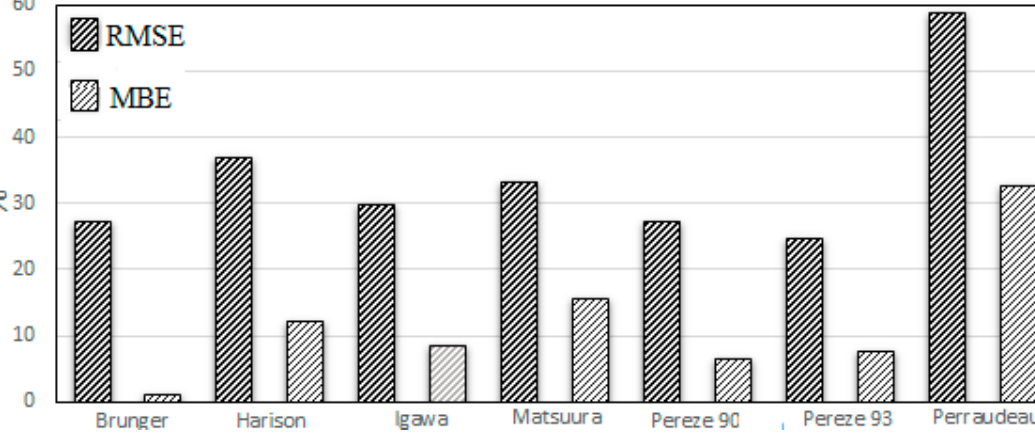
Figure 7. RMSE and MBE for the investigated models (partly cloudy sky).